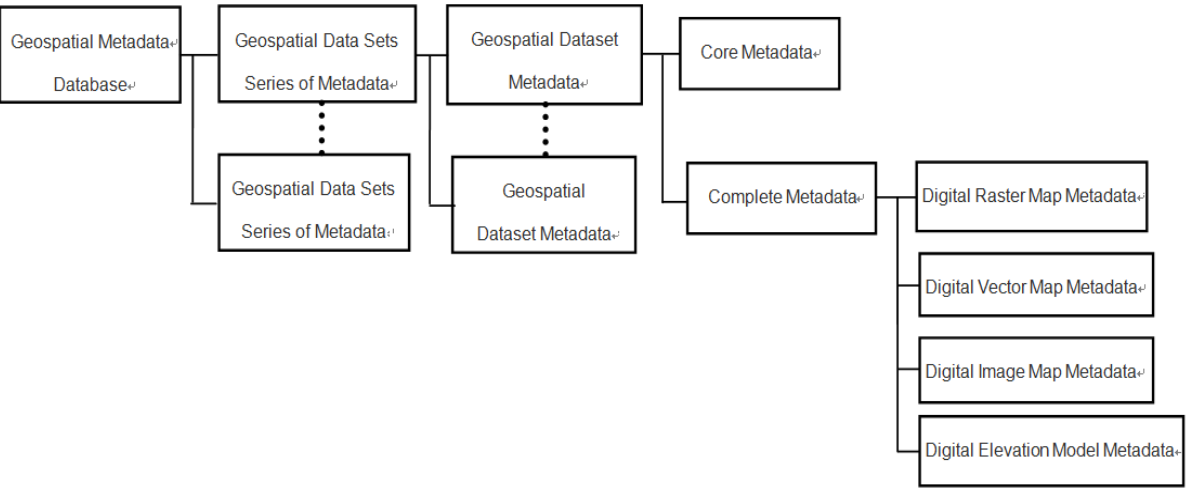
Figure 1 Geospatial Metadata system